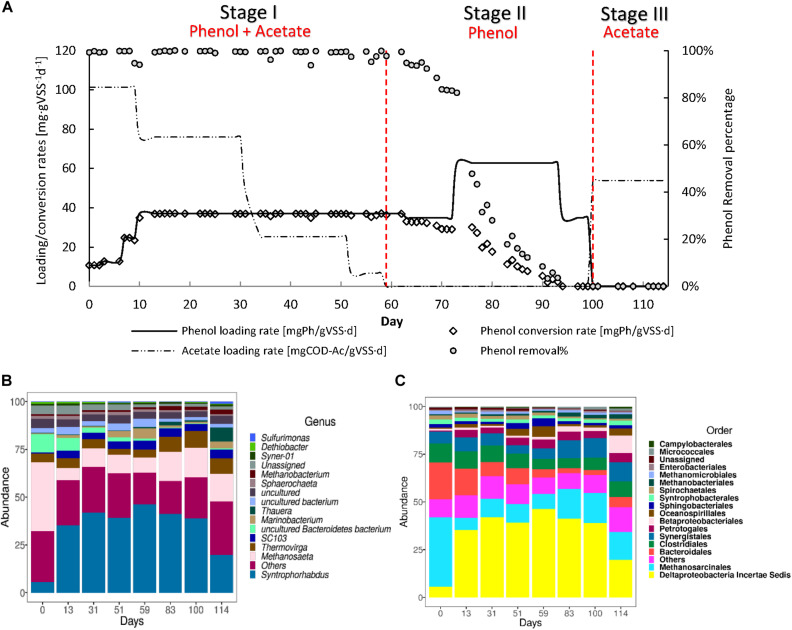
Operation (A) and microbial community dynamics (B,C) of the R1 toward the usage of phenol as the main carbon and energy source (CES). The graph in (A) shows the phenol loading and conversion rates, the acetate loading rate, and the phenol removal percentage during the AnMBR operation. (B,C) shows the microbial community dynamics, as the more abundant microbial order (B) or genus (C) during the different operational days.